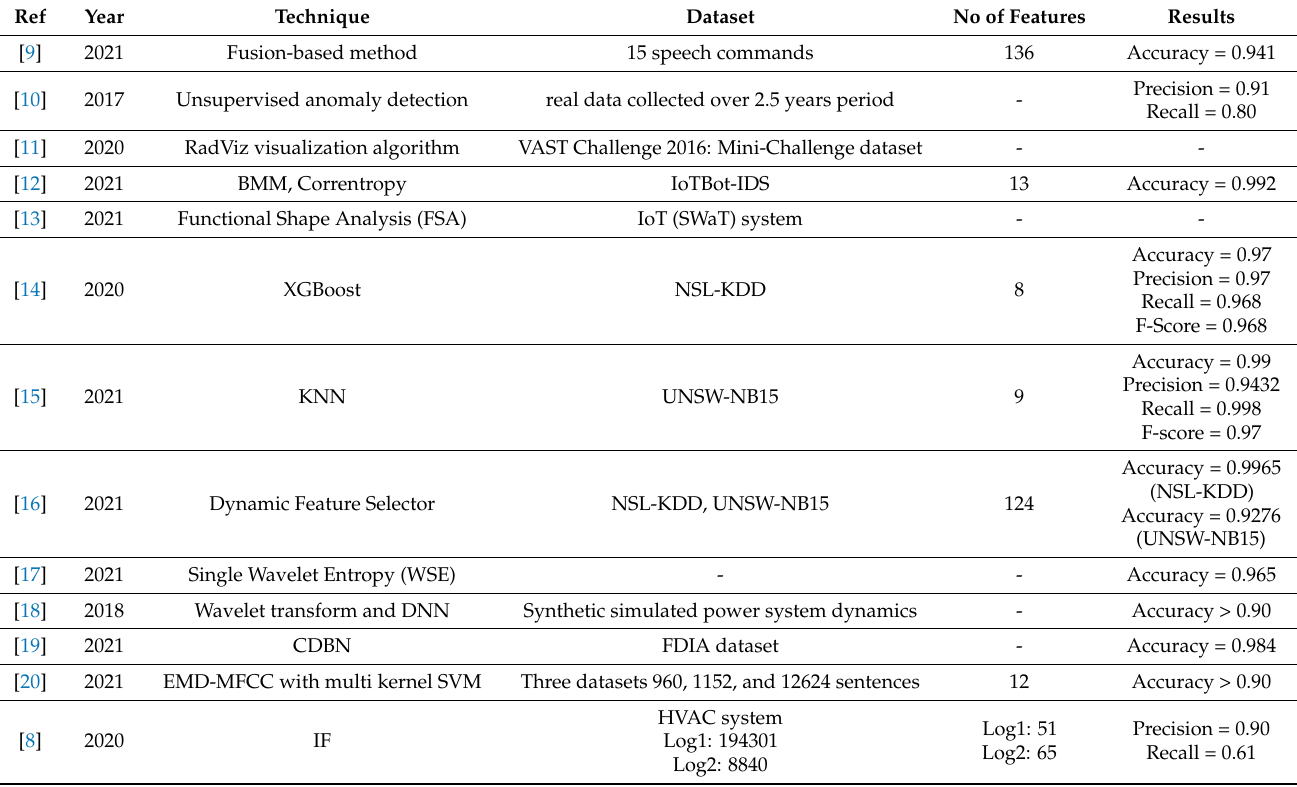
Table 1. Summary of the previous related